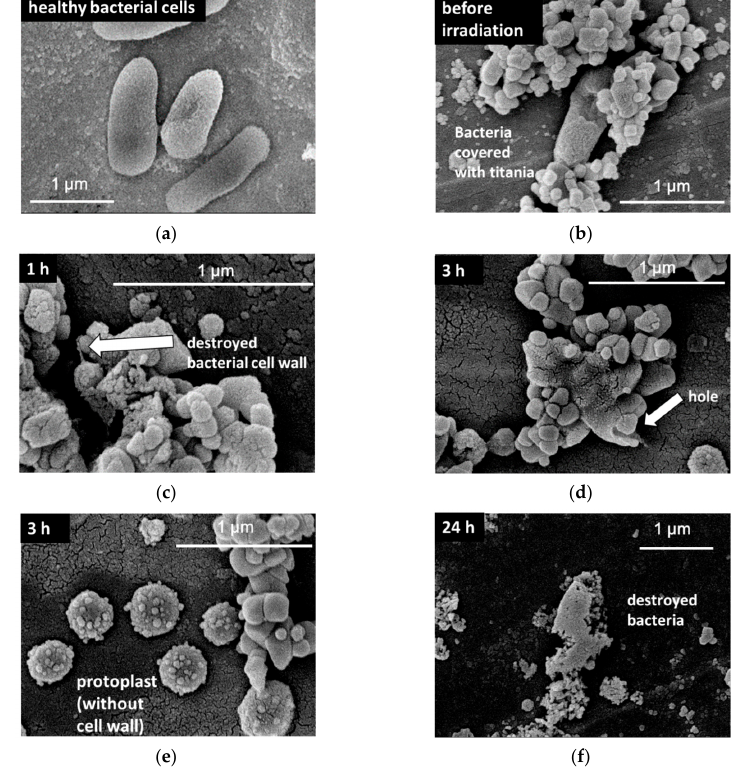
Figure 3. SEM images of the decomposition of E. coli under vis ( λ > 420 nm) irradiation of Ag/TiO 2 photocatalyst: ( a ) healthy bacteria cells, ( b ) bacteria covered with titania before photocatalytic reaction, ( c , f ) destroyed bacteria cells after: ( c ) 1 h, ( d , e ) 3 h and ( f ) 24 h of irradiation; adapted with permission from [115]. Copyright 2018, Creative Commons Attribution.